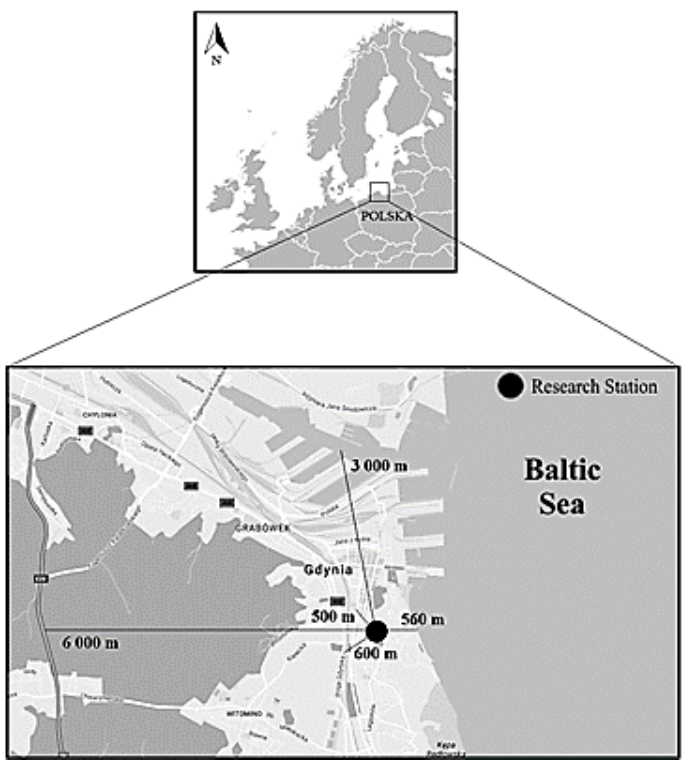
Figure 1. Location of the measuring station along with the surrounding traffic routes. In the vicinity of the measuring station, there is increased traffic in the morning and afternoon hours, which is mainly related to the presence of numerous schools to which children are transported (Figure 2). The closest of them is located 128 m and the farthest 690 m away from the measuring station.